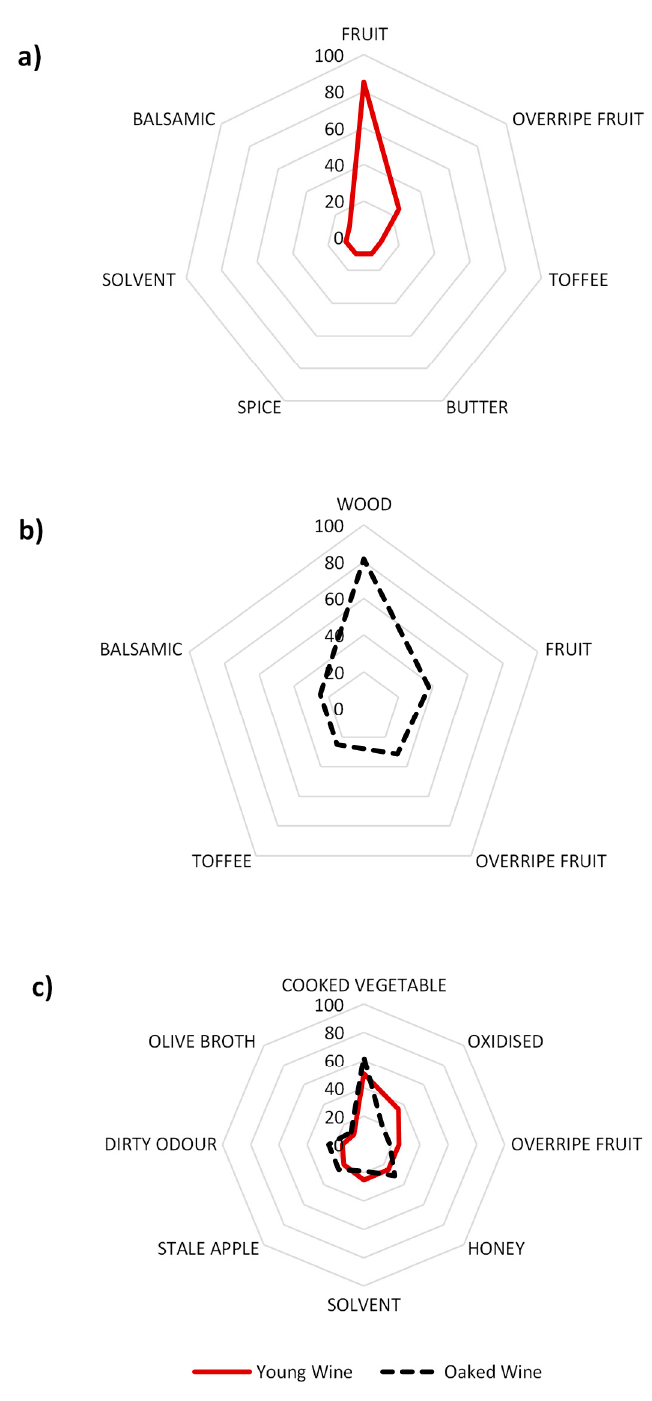
Figure 2. Citation frequency percentage of attributes related to ( a ) young wine with high aroma quality, ( b ) oaked wine with high aroma quality and ( c ) young and oaked wines with low aroma quality.